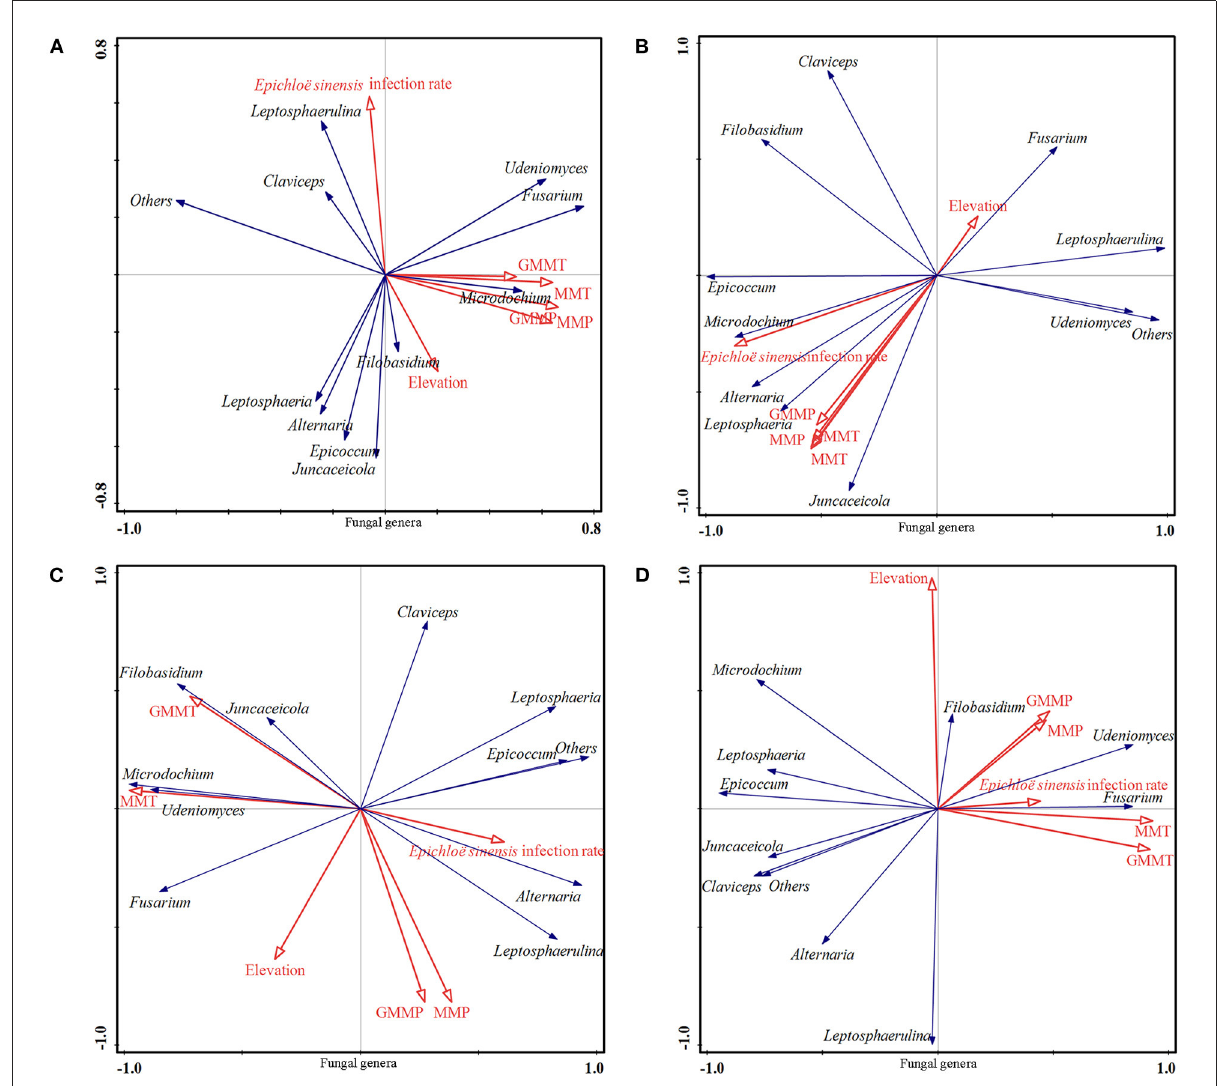
FIGURE8 Effect of environmental factors on fungal genera. (A) on overall elevation (2,589–5,197m). (B) on high elevation (2,589–3,000m); (C) on medium-high elevation (3,000–4,500m); (D) and on extremely high elevation (4,500–5,197m). The microbial parameters (expressed as response variables in the RDA) were presented as black line vectors, and the environmental factors (explanatory variables) were presented as red line vectors. MMT, monthly mean temperature; MMP, monthly mean precipitation; GMMT, growing monthly mean temperature; GMMP, growing monthly mean